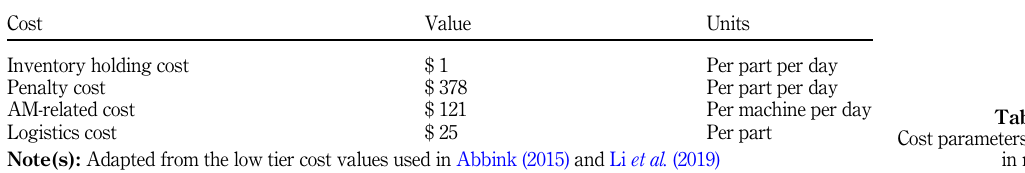
Table 2. Cost parameters